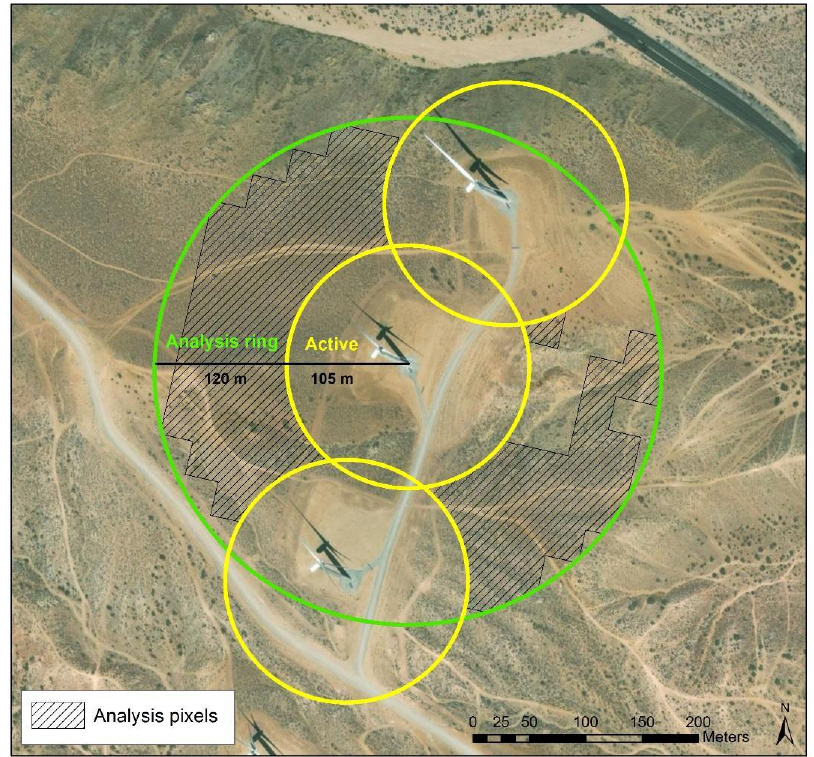
Figure 3. Sampling occurred within a ring extending from 105 to 225 m from the turbine. The active areas within 105 m of the turbine were excluded from analysis, as were disturbed pixels within the outer ring.